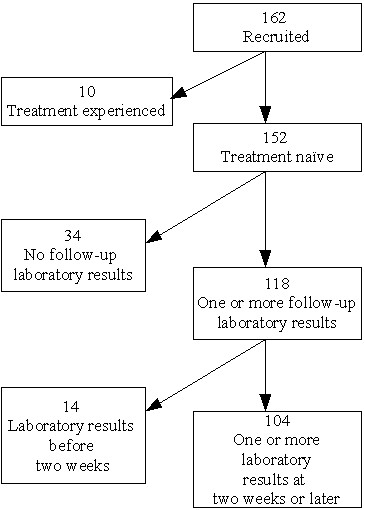
Cohort profile. 34 patients had no follow-up laboratory records at 4 weeks. In 12 of the 34 patients, end point events including eight deaths occurred before the planned first visit.